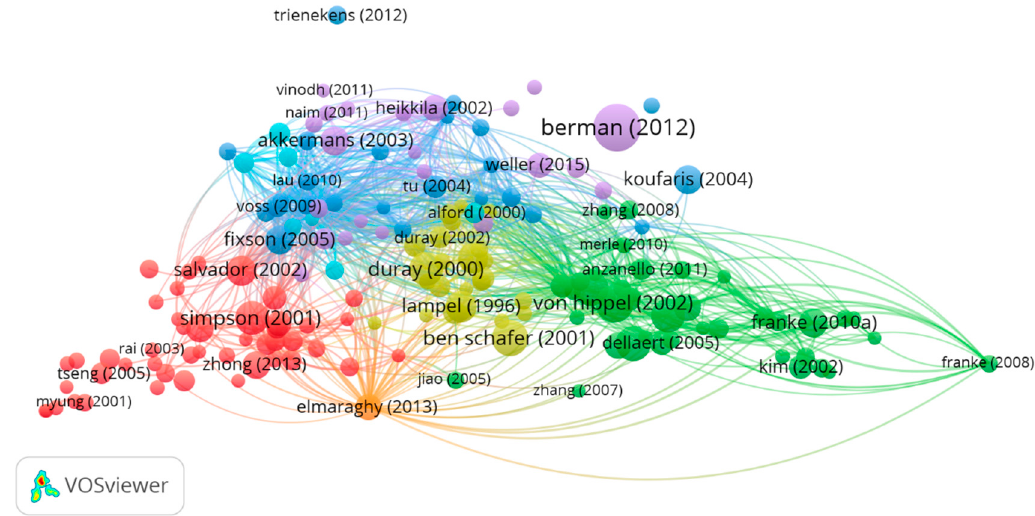
Figure 3. Bibliographic coupling of Mass Customization publications in 1990–2020. Source: Composed by the authors using VosViewer software.